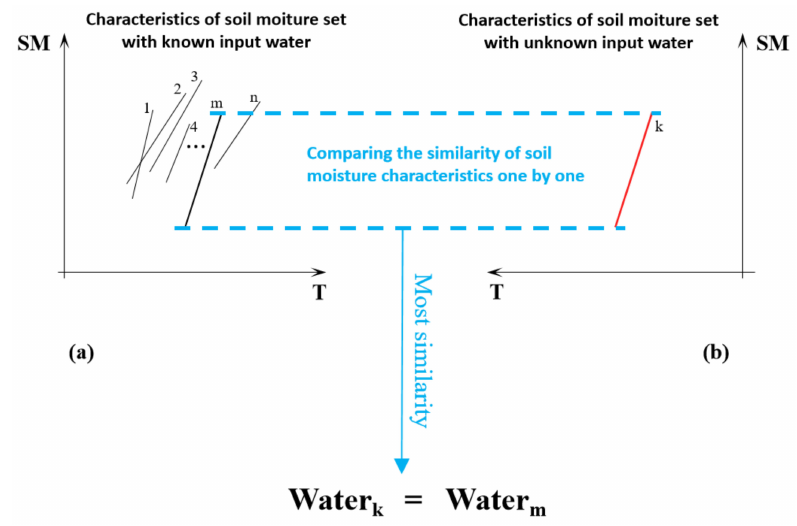
Figure 1. Surface water input prediction based on the similarity of soil moisture